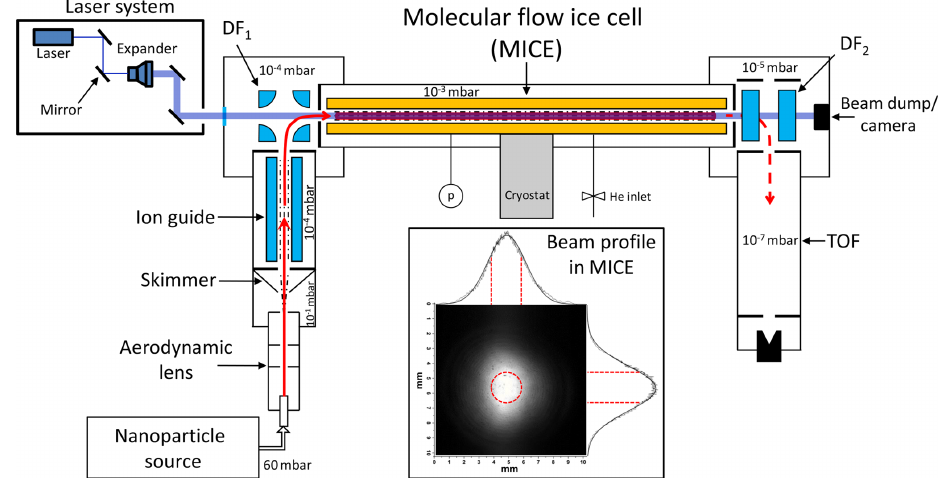
Figure 1. Illustration of the experimental setup. The insert shows a camera image of the laser beam profile ( λ = 488nm) taken at the exit of MICE. Vertical and horizontal cross sections of the laser beam profile are shown above and right of the image, overlaid with fitted Gaussian curves. The red dashed lines indicate the radial extent of the levitated nanoparticle cloud. See the text for more details.